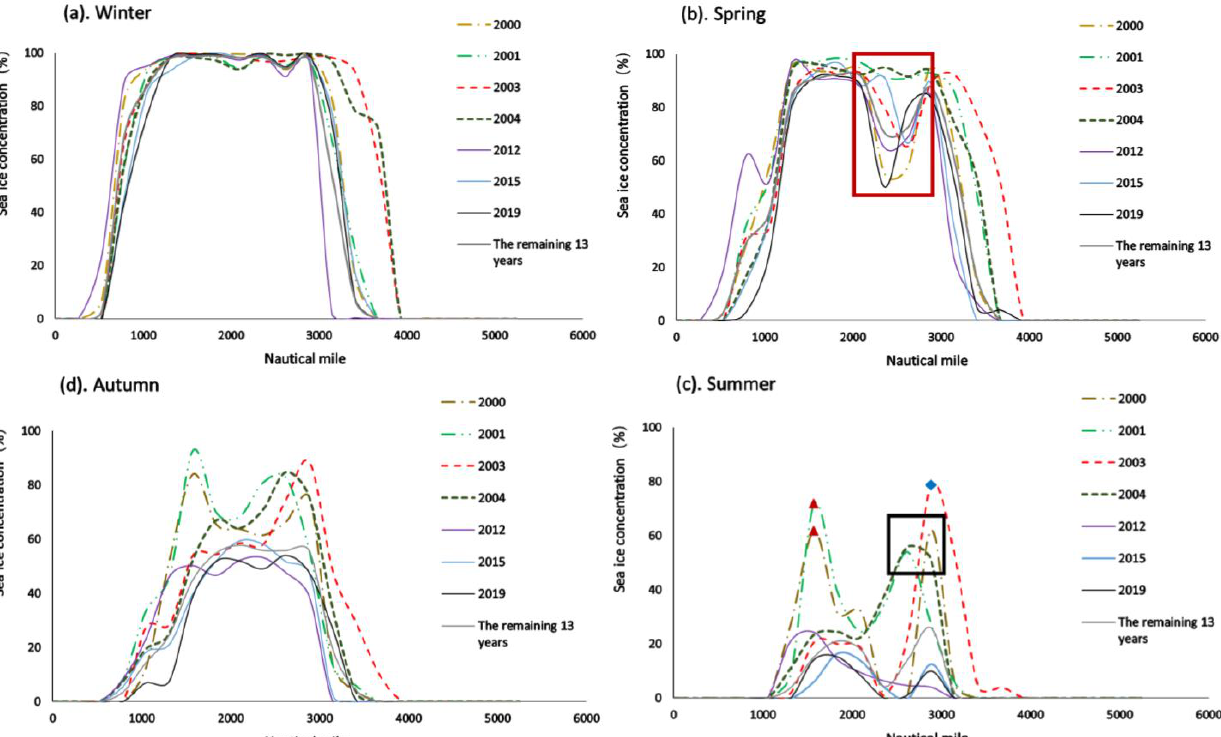
Figure 3. The average sea ice concentration of the NEP from 2000 to 2019, ( a ) is winter, ( b ) is spring, ( c ) is summer, and ( d ) is autumn. Among them, the red box in ( b ) represents the variation in the average sea ice concentration in spring in the Laptev Sea. In ( c ), the red triangles indicate that the sea ice concentration in the East Siberian Sea in 2000 and 2001 was higher than 60%, the blue diamond indicates that the sea ice concentration in the Vilkitsky Strait in 2003 was higher than 80%, and the black box indicates that the sea ice concentration in the Vilkitsky Strait in 2000, 2004 and 2001 was respectively above 50%.